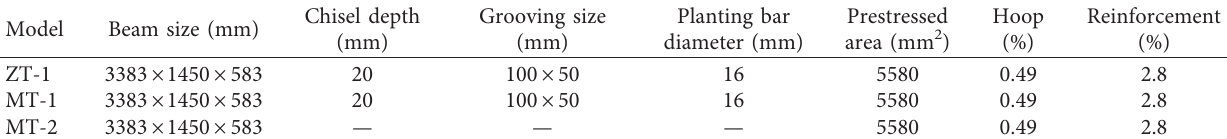
Table 1: Dimension parameters.